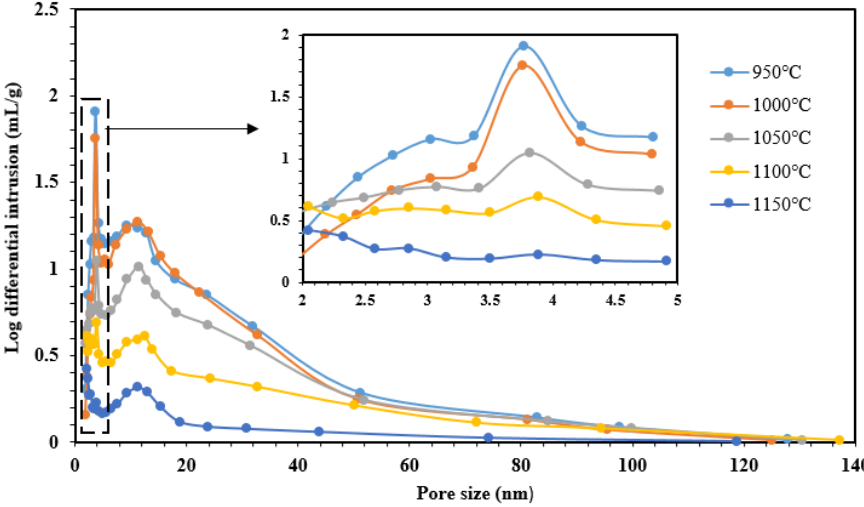
Figure 6. Pore size distribution of ceramic membranes sintered at different temperatures for 3 h.